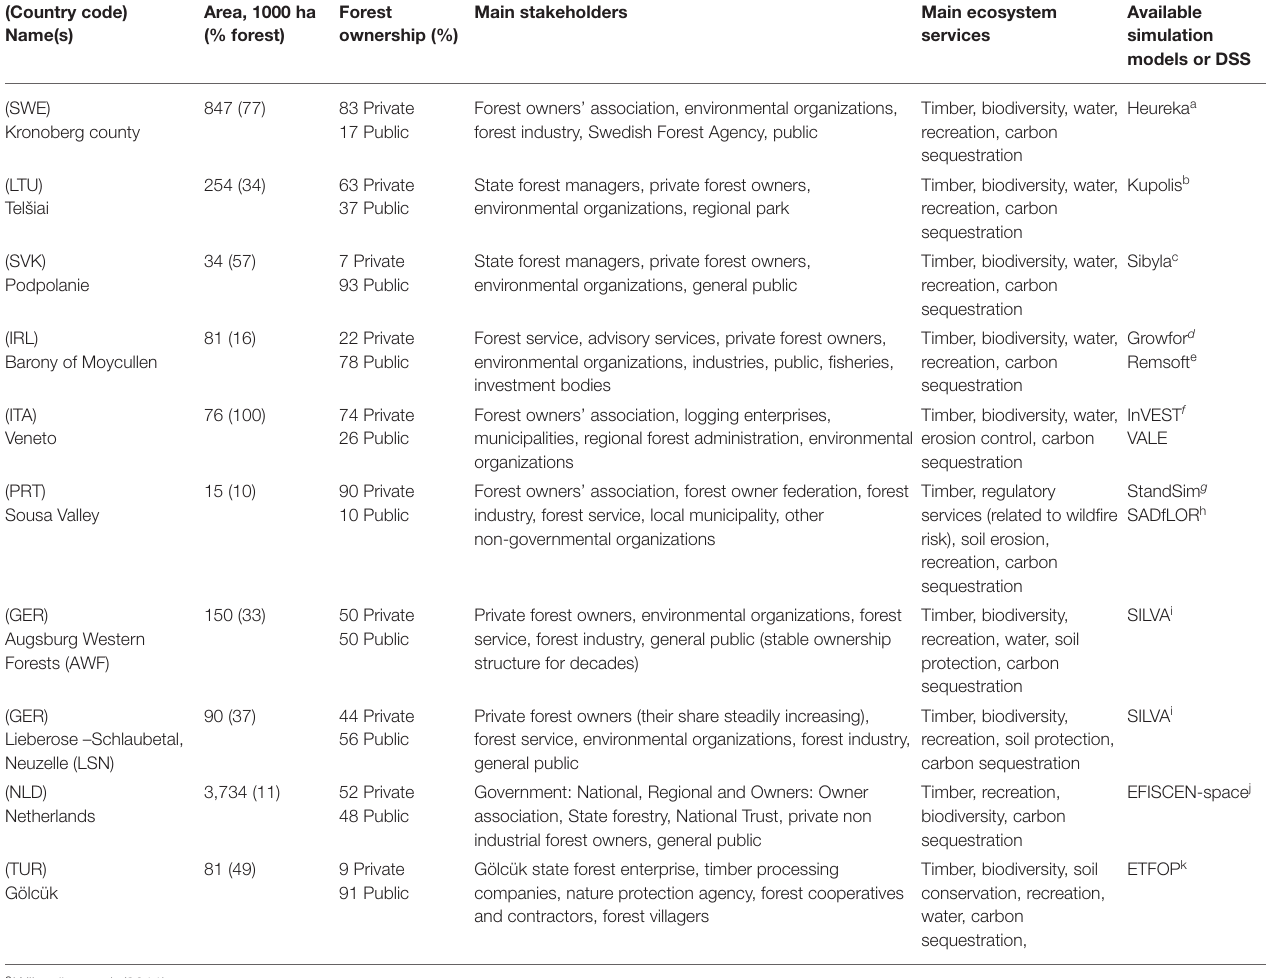
TABLE 1 | Case study landscapes used in this study [taken from Biber et al. (2019), modified]. (Country code)